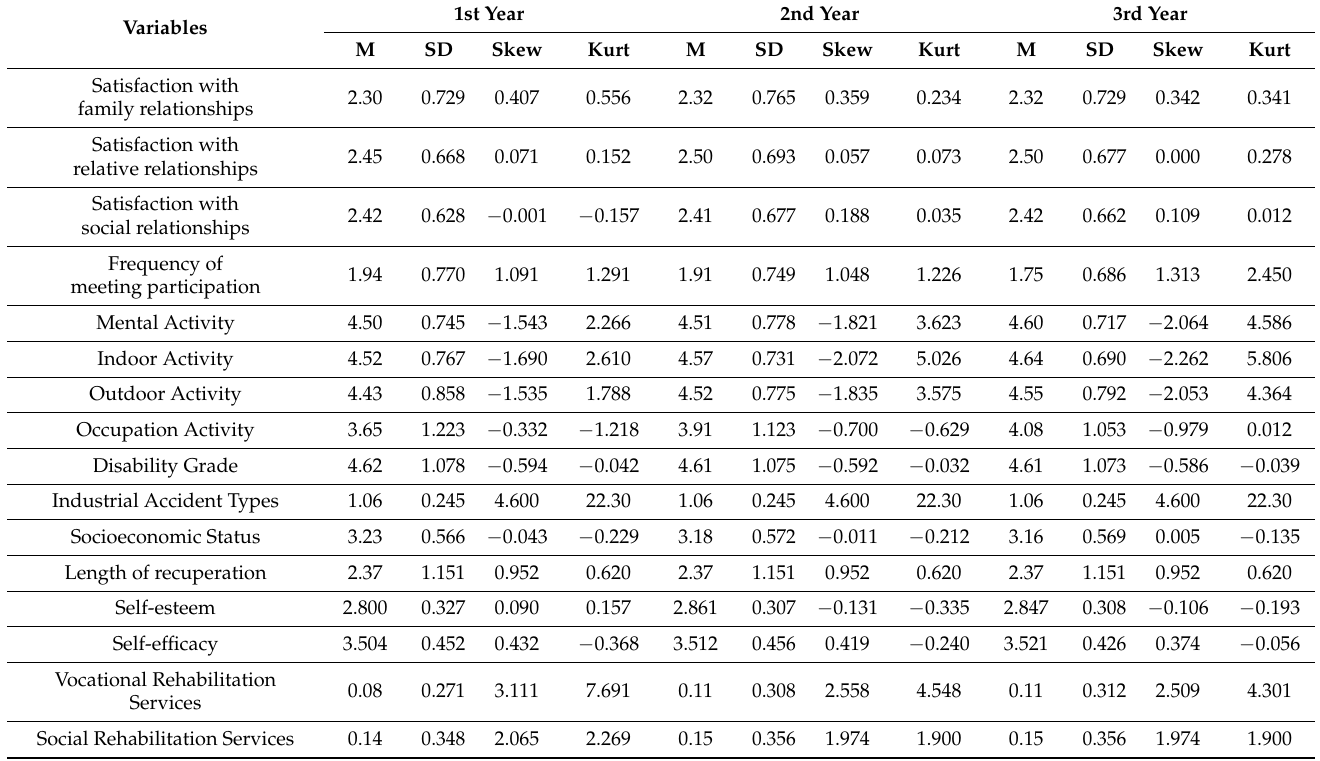
Table 5. Descriptive statistics of